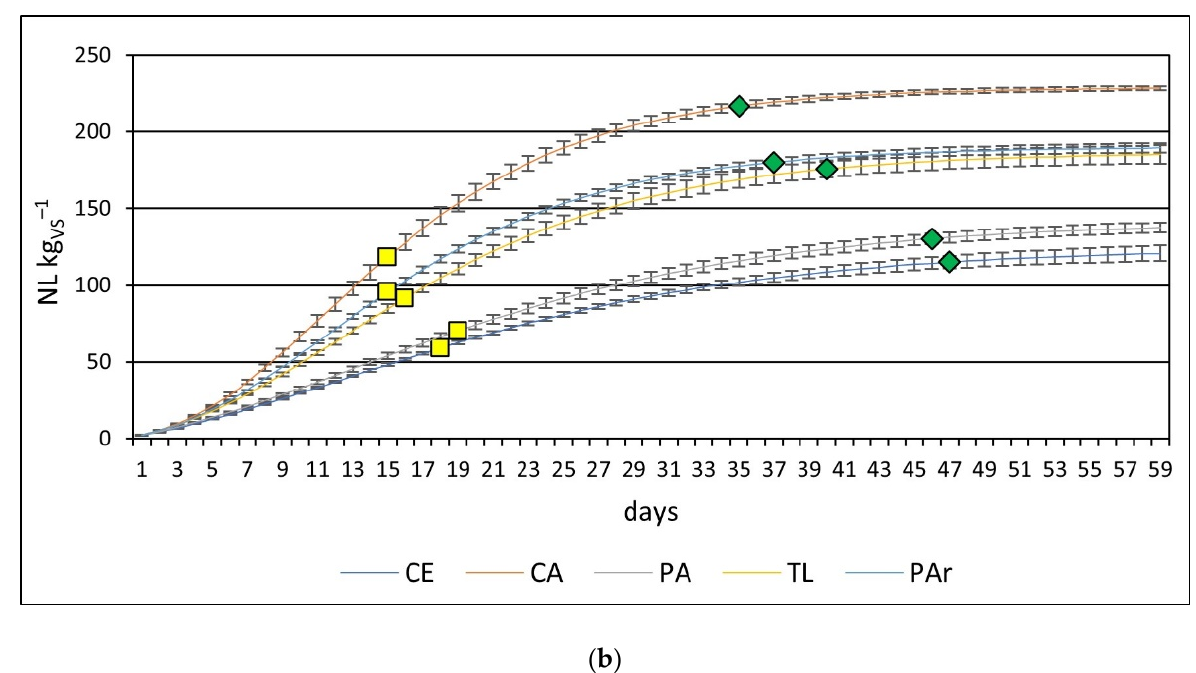
Figure 4. Cumulative methane production: ( a )—wet fermentation; ( b )—dry fermentation. CE— Carex elata ; CA— Carex acutiformis + Carex elata ; PA— Phragmites australis ; TL— Typha latifolia ; PAr— Phalaris arundinacea . Standard errors are shown as vertical bars. The yellow squares and green diamonds indicate T50 and T95, respectively.